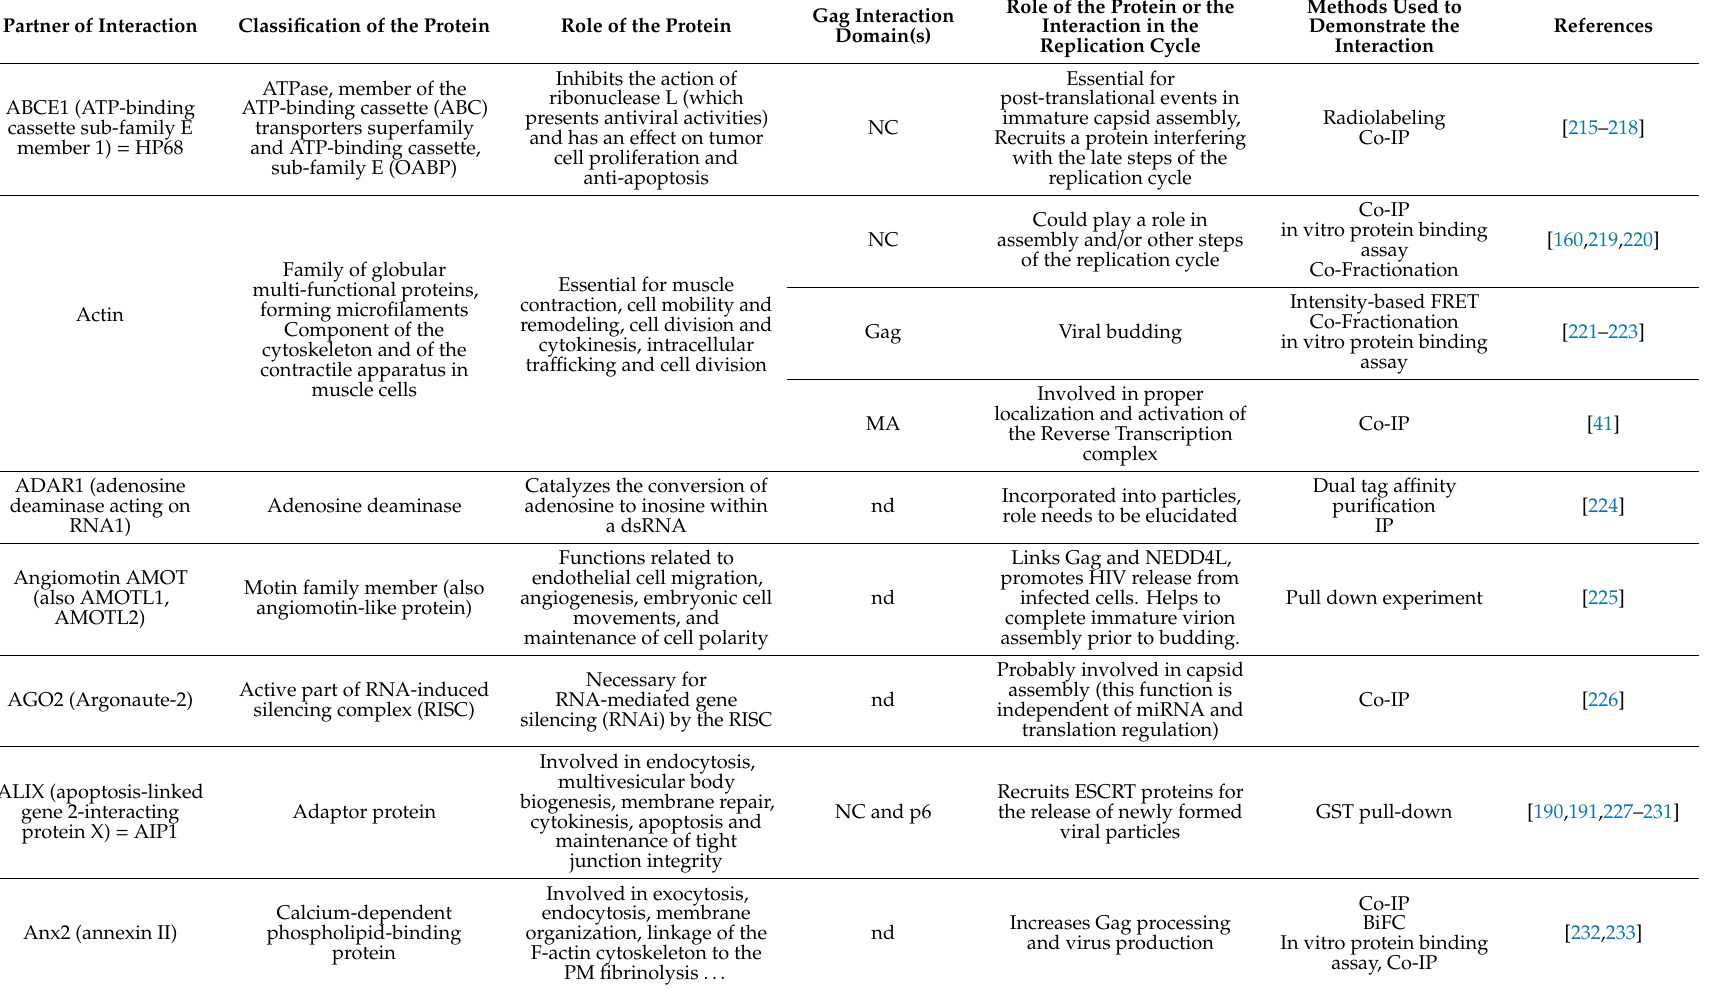
Table 1. Cellular proteins interacting with HIV-1 Gag